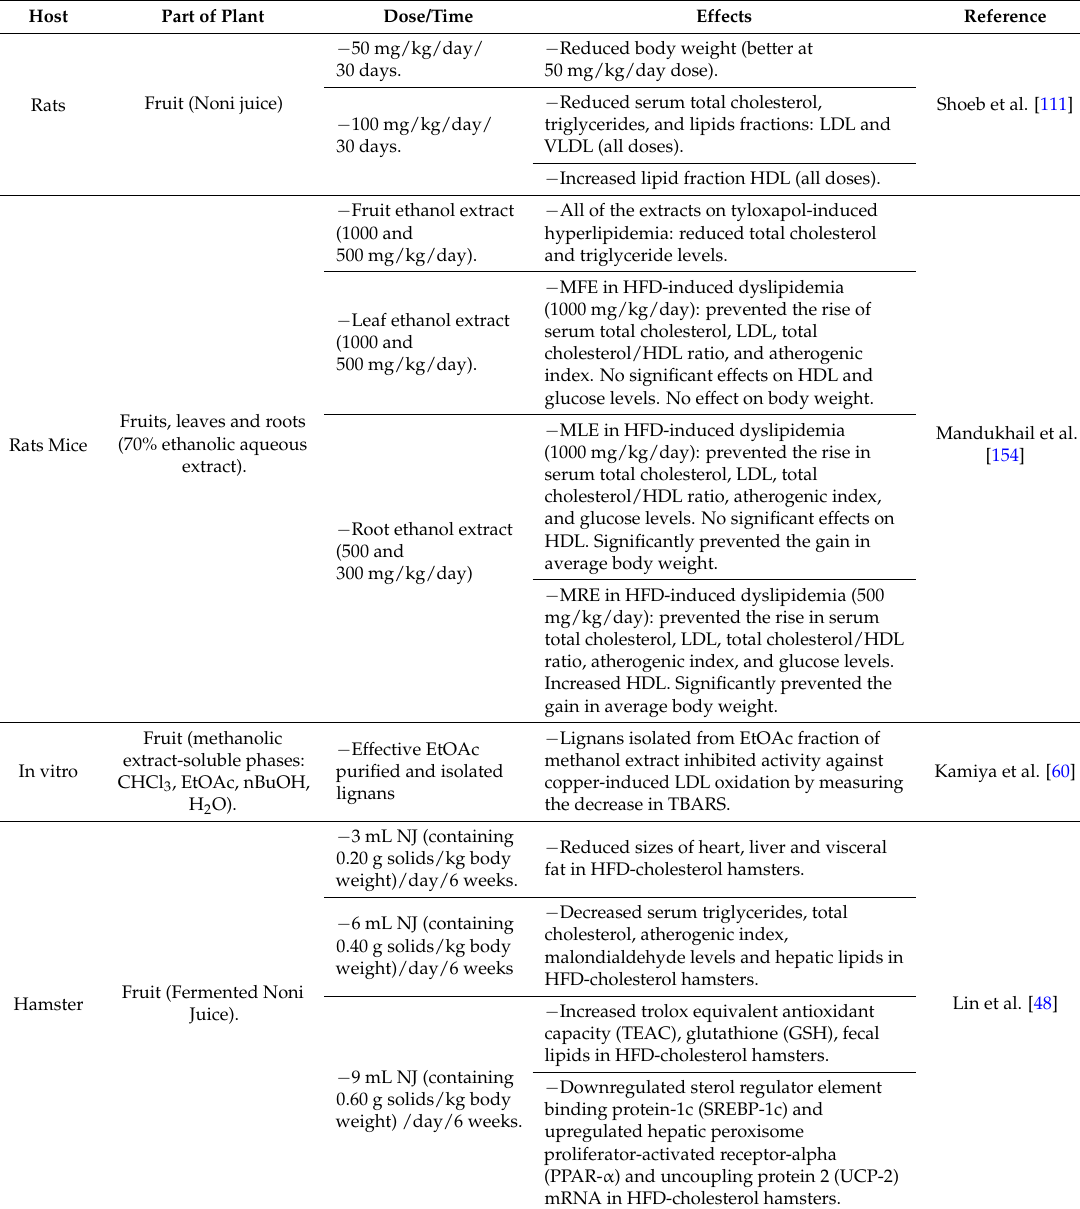
Table 5. The effects of administration of the Morinda citrifolia L. plant on